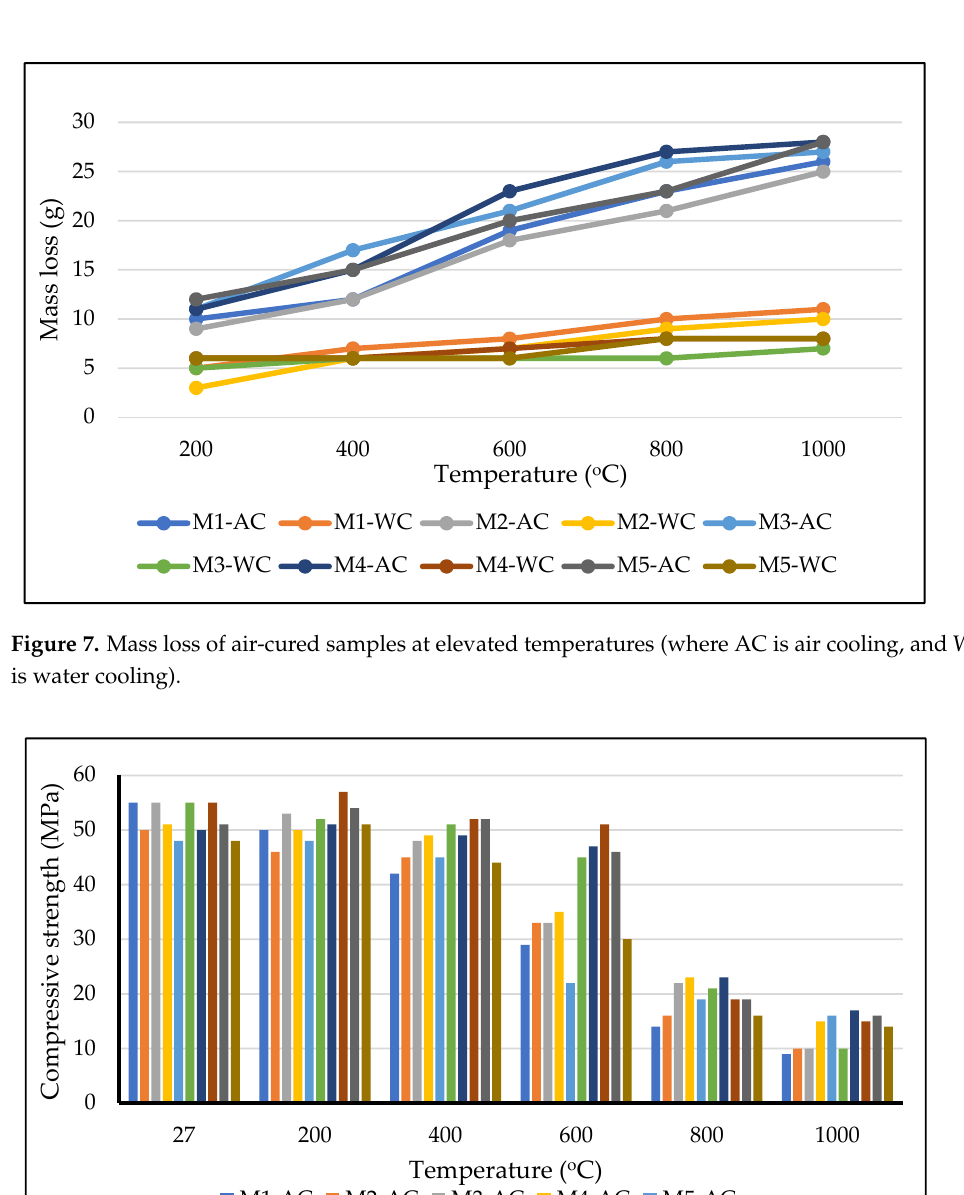
Figure 8. Compressive strength of full-water-cured samples at elevated temperatures (where AC is air cooling, and WC is water cooling).